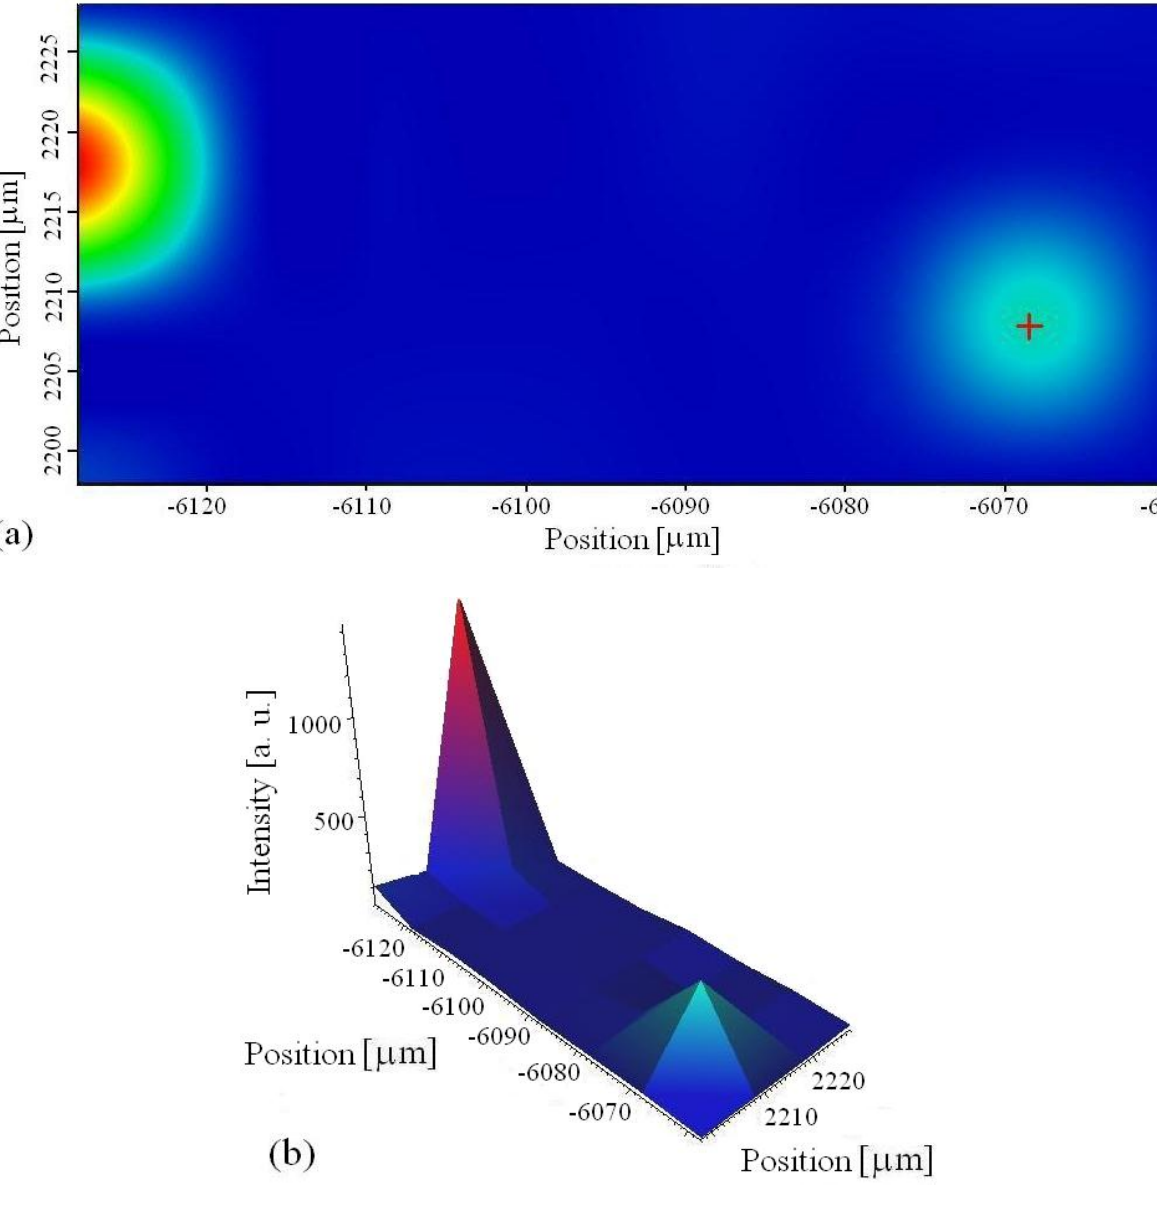
Figure 6. Mapping image of tungstant oxides from bronze in: (a) 2D; (b)